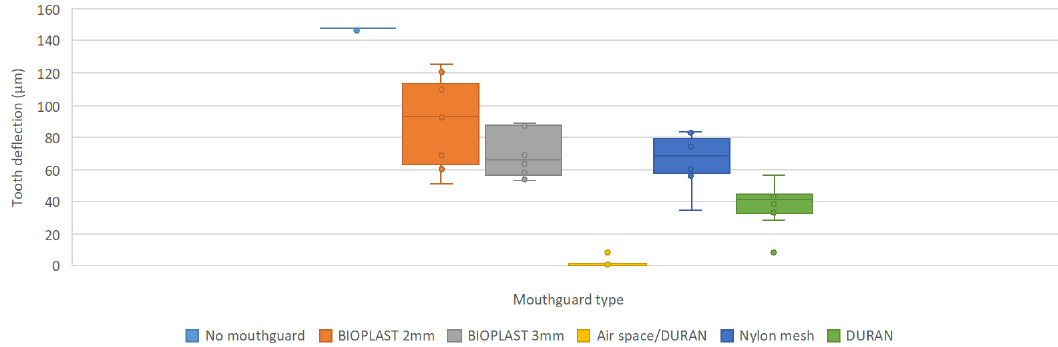
Figure 4. Box-whisker plots of all five mouthguard types’ average maximum deflection values and maximum deflection values with no mouthguard with 90 ◦ pendulum energy blows (generated energy: 1.15J).